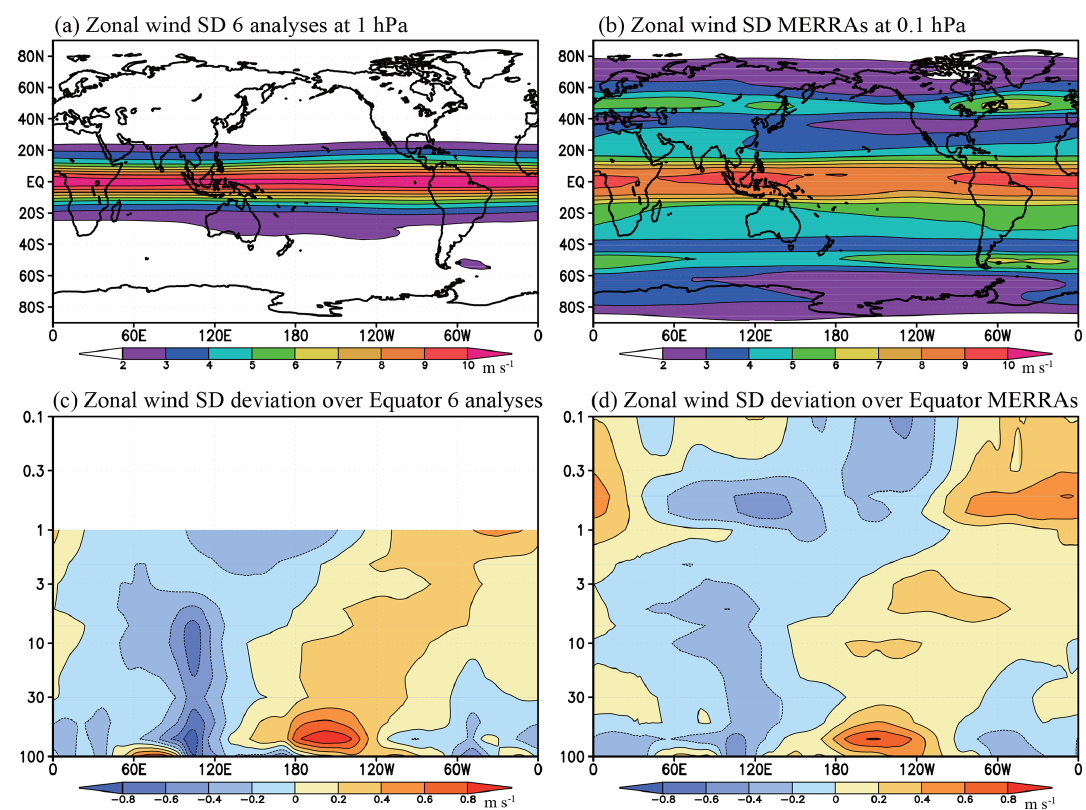
Figure 6. (a, b) Horizontal maps of climatological zonal wind standard deviation (a) among the six reanalyses at 1hPa and (b) between MERRA and MERRA-2 at 0.1hPa. (c, d) Longitude–height cross section of the anomaly of the zonal wind standard deviation from its zonal mean over the Equator (c) among the six reanalyses and (d) between MERRA and MERRA-2. The color intervals are 1ms − 1 for (a, b) and 0.2ms − 1 for (c, d)